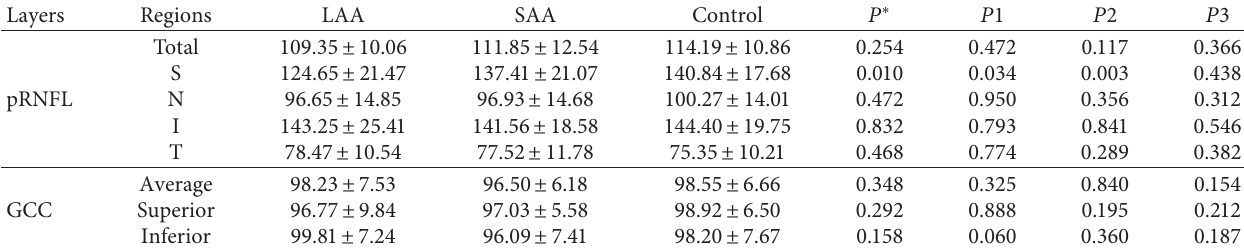
Table 3: Retinal thickness ( μ m) from commercial instruments in patients with LAA, SAA, and controls. Layers